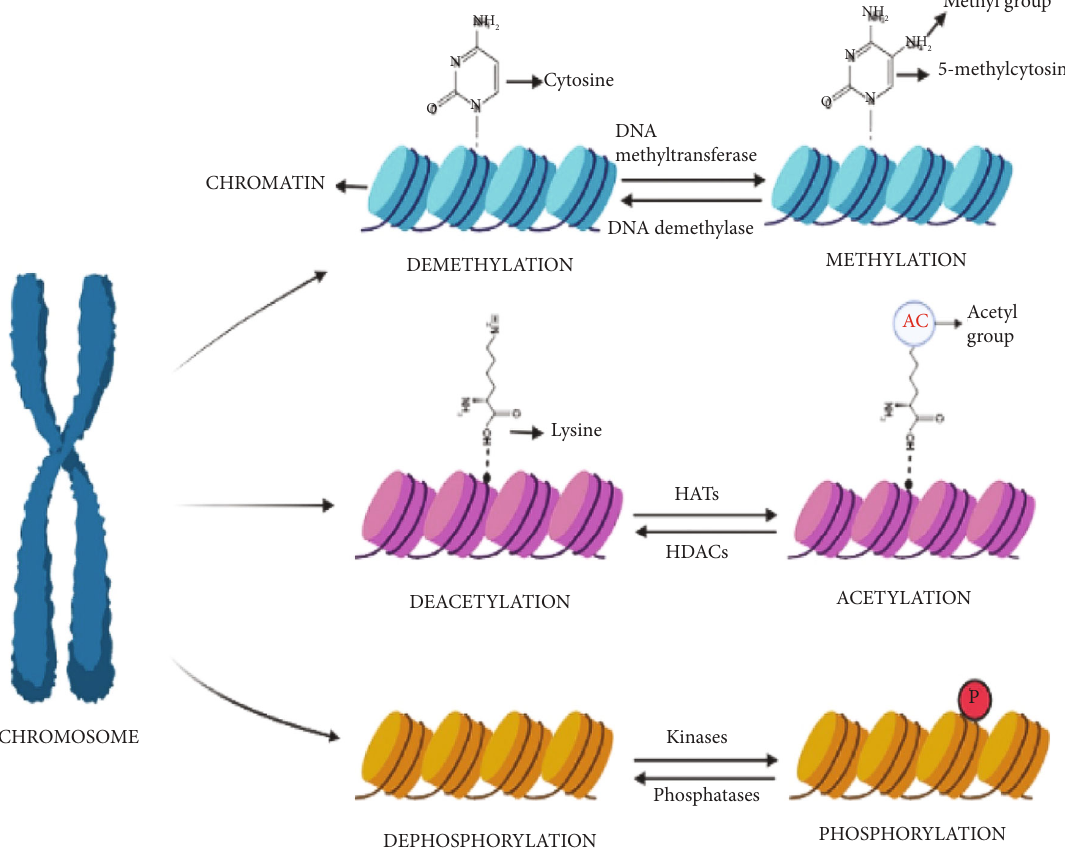
Figure 2: Various epigenetic modi fi cations include acetylation, (de)methylation, and phosphorylation. DNA methylation involves the addition of a methyl (-CH ) group to the fi fth position of cytosine known as methylcytosine (5-mC). This process is carried by DNA 3 methyltransferases while the demethylation process is aided by DNA demethylase. Acetylation, i.e., the addition of negatively charged acetyl group to lysine residues on histone proteins is regulated by two opposing enzymes, i.e., histone acetyltransferases (HATs) and histone deacetylases (HDACs). Acetyl group addition is catalyzed by HATs while the removal of acetyl groups is catalyzed by HDACs. Phosphorylation is one of the important histone modi fi cations. Histone phosphorylation plays a role in DNA repair, synchronization of chromosome segregation, and cell division. Histone tails can be phosphorylated by various protein kinases and dephosphorylated by phosphatases. All the histone modi fi cations lead to the regulation of gene